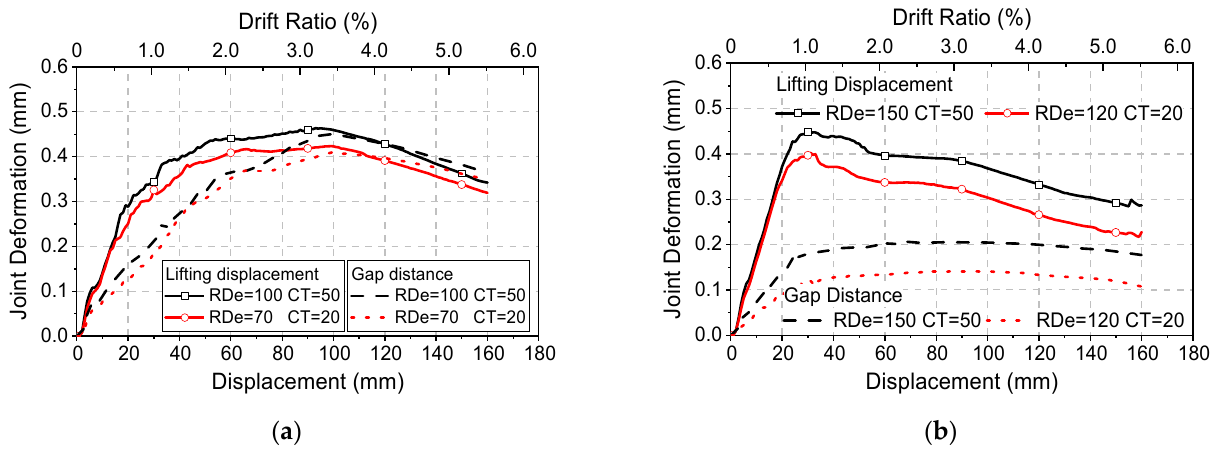
Figure 24. Joint deformation curves of different cushion thicknesses: ( a ) shallow recess (effective RDe = 50 mm); ( b ) deep recess (effective RDe = 100 mm).